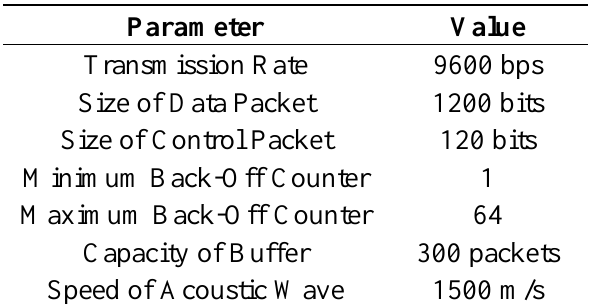
Table 1. System parameters and